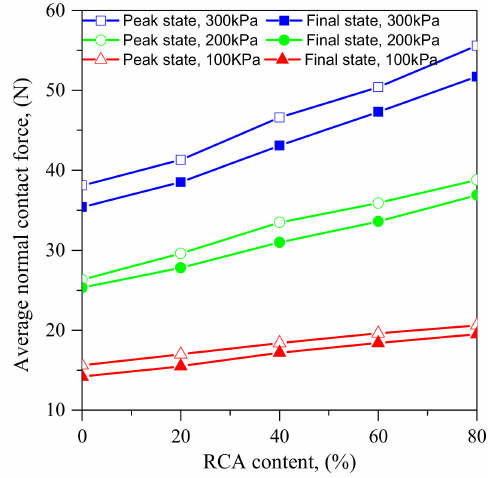
Figure 13. Relationships between RCA content and average contact forces of samples under various confining stresses in the peak state and final